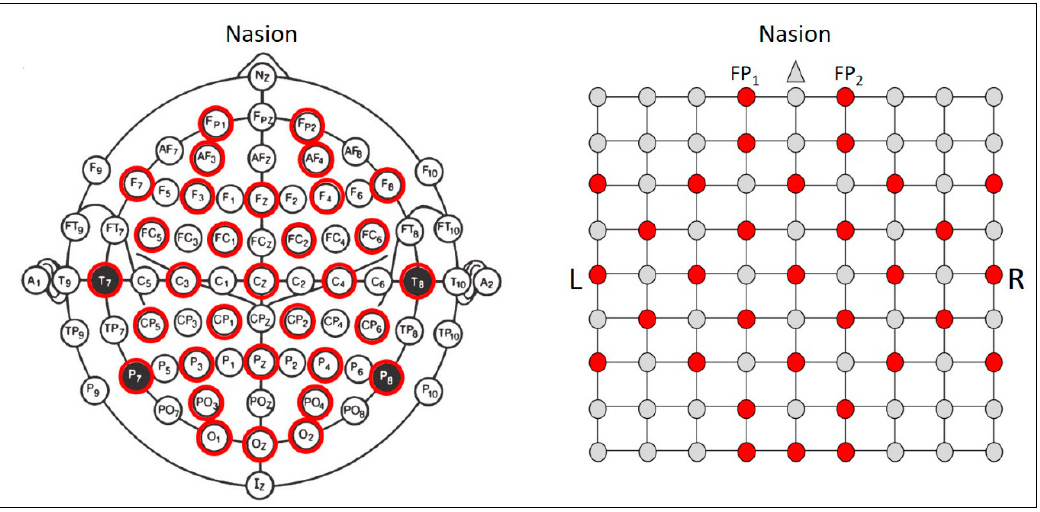
Figure 1. The International 10-20 System and the corresponding square EEG feature matrix (9 × 9) with tested EEG electrodes (the red points are tested in the trial and the gray points are not